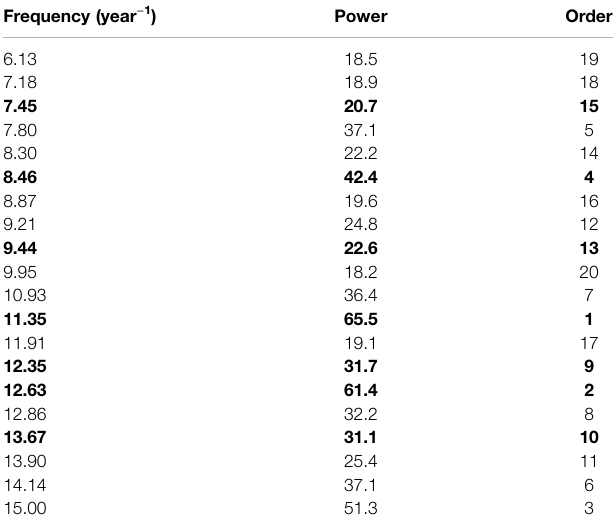
TABLE 4 | Top 20 peaks in the power spectrum formed from midnight data in the frequency band 6 – 16 years − 1 Entries in bold comprise a triplet and